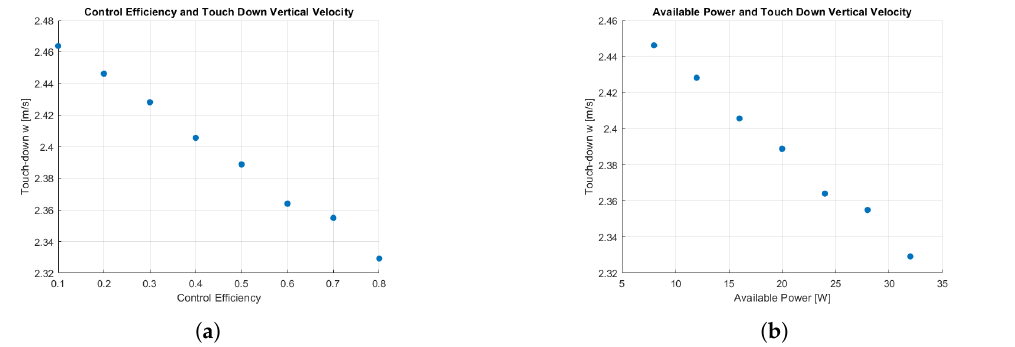
Figure 18. Touchdown vertical velocity for different control efficiency and currents for a parafoil of 280 m 2 surface and a mass of 2028 kg. ( a ) Touch-down vertical velocity with different efficiency as input to the control algorithm; ( b ) touch-down vertical velocity with different available current as input to the control